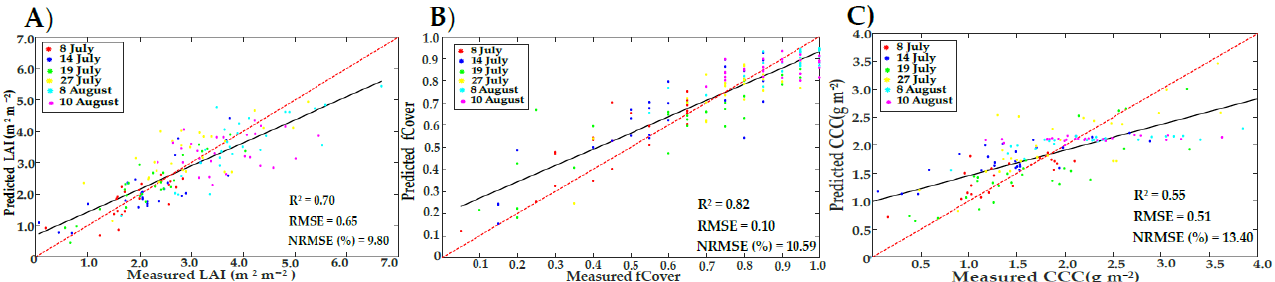
Figure 6. Scatterplots of LAI, fCover, and CCC predicted from hybrid models based on GPR ( A ), RF ( B ), and CCF ( C ), respectively; with trend lines for linear fitting (black) and 1:1 line (dashed